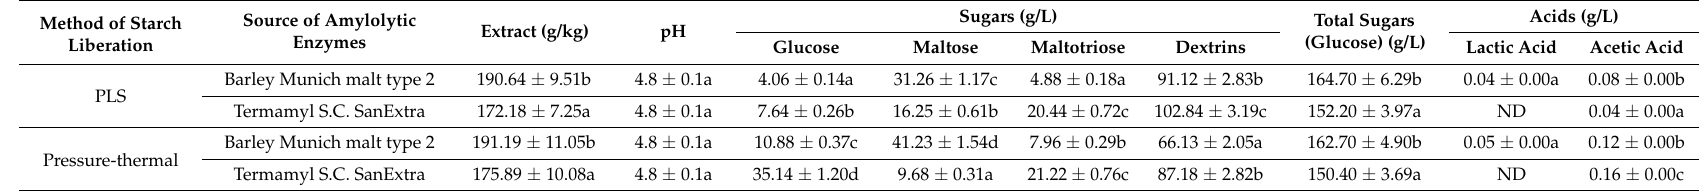
Table 2. Chemical composition of sweet mashes.